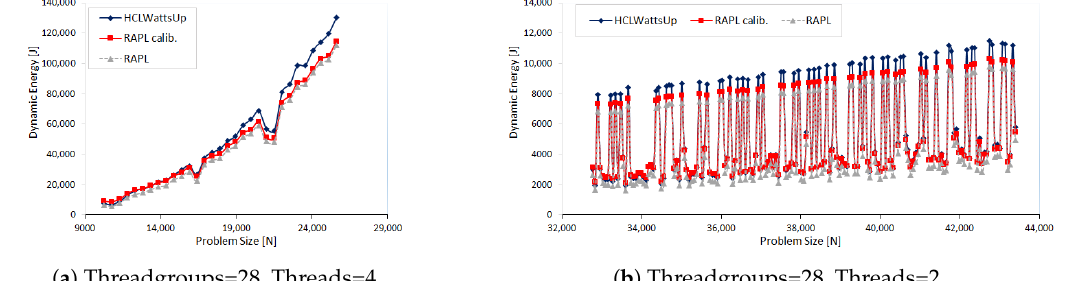
Figure 3. Dynamic energy profiles by RAPL and HCLWattsUp on HCLServer03, class B. RAPL calib. means that RAPL readings have been calibrated. ( a ) DGEMM, N = 10,240–25,600, ( b ) MKL-FFT, N =